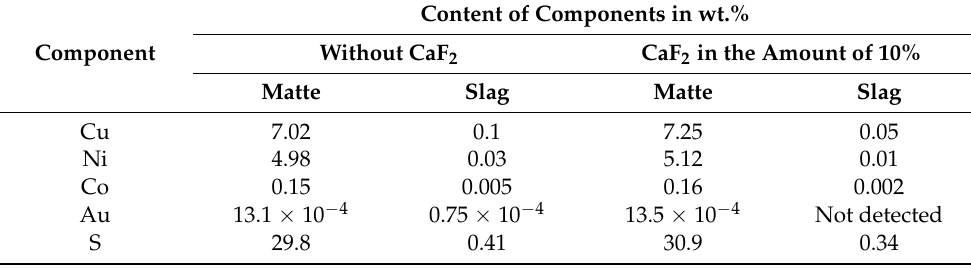
Table 5. Content of sulfur, non-ferrous, and noble metals in matte and slag after melting the charge without and with the addition of CaF 2